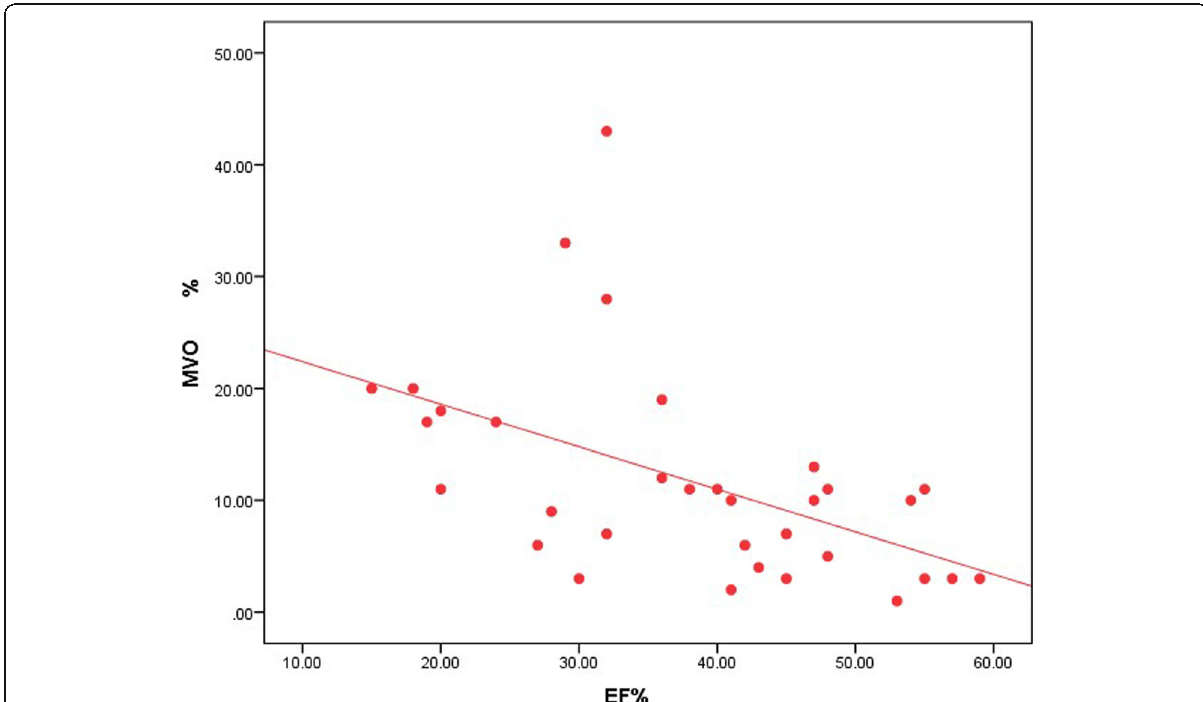
Fig. 3 A scatter plot matrix showing a significant inverse correlation between MVO size % and LVEF% measured at the 2nd visit